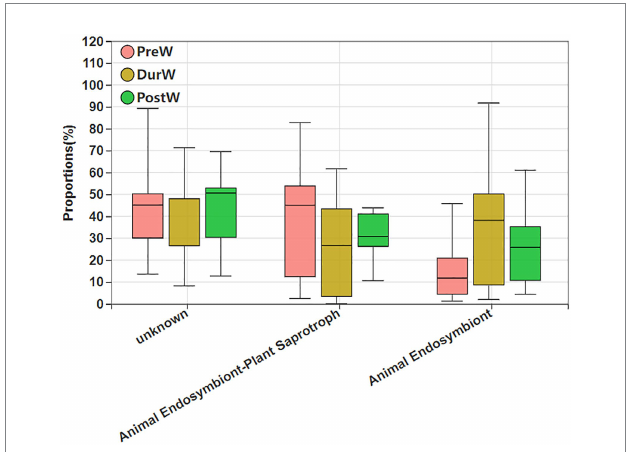
FIGURE 10 Variations in composition of anaerobic fungi functional groups inferred by FUNGuild. FUNGuild, fungi functional guild; PreW, pre-weaning donkeys; DurW, during weaning donkeys; PostW, post-weaning